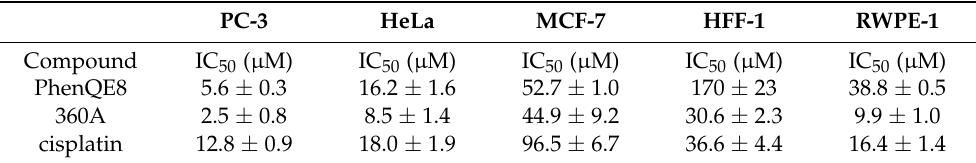
Table 2. Cytotoxic activity of PhenQE8 and cisplatin in tumor PC-3 (prostate), HeLa (cervix), and MCF-7 (breast) cultured cells and in healthy HFF-1 (fibroblasts) and RWPE-1 (prostate) cells, after a 72-h incubation period. PC-3 HeLa MCF-7 HFF-1 RWPE-1